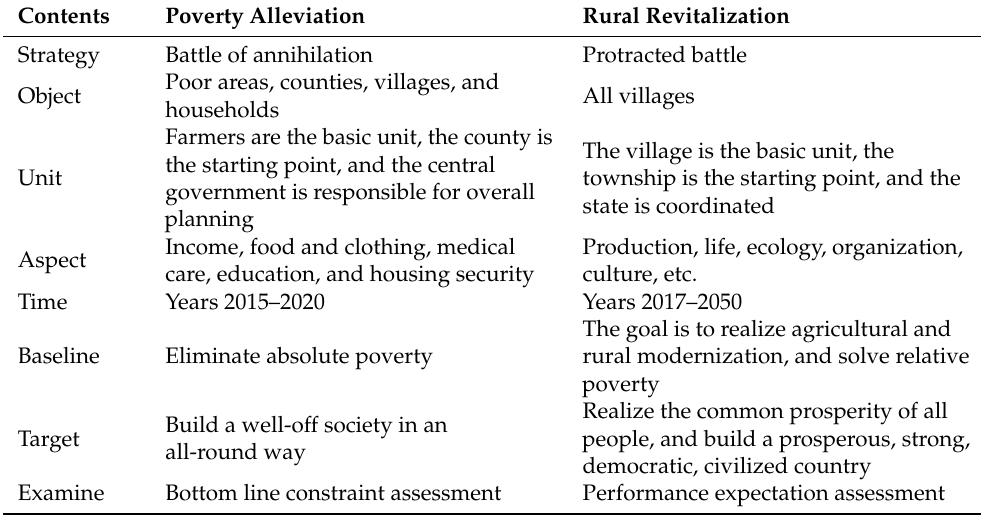
Table 1. The distinction between targeted poverty alleviation and rural